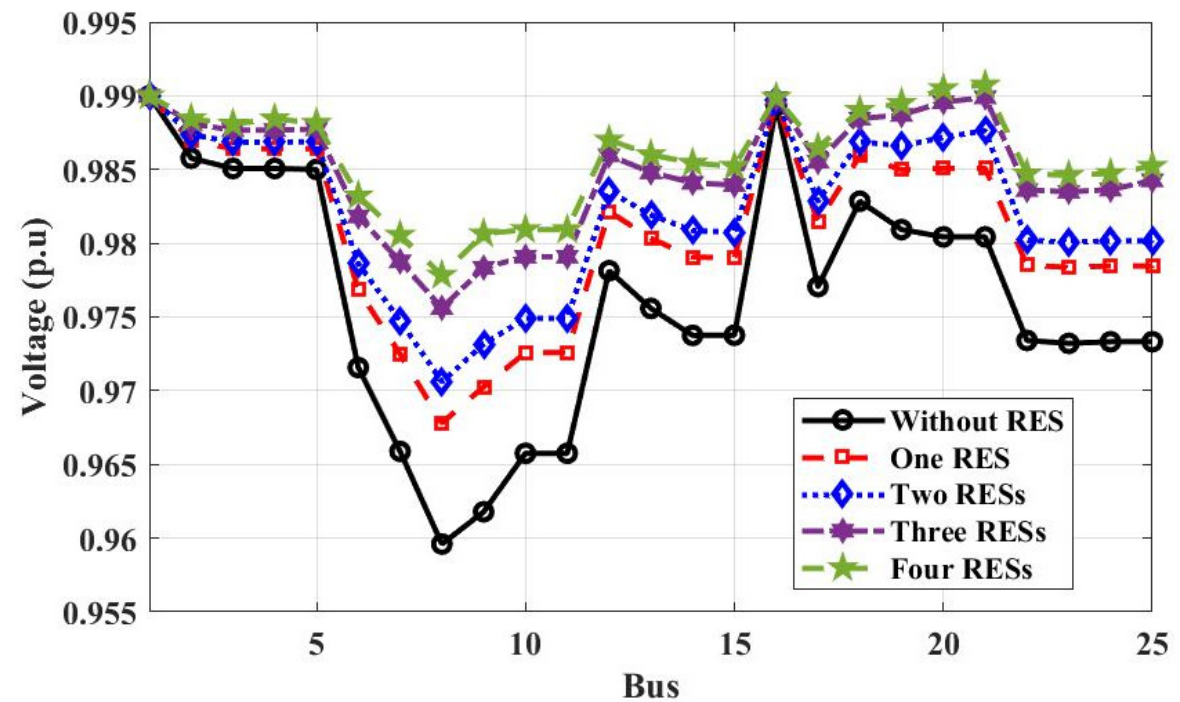
Figure 19. Voltage profile of 25-bus 500 kV EPS without and with RESs for power loss calculation.